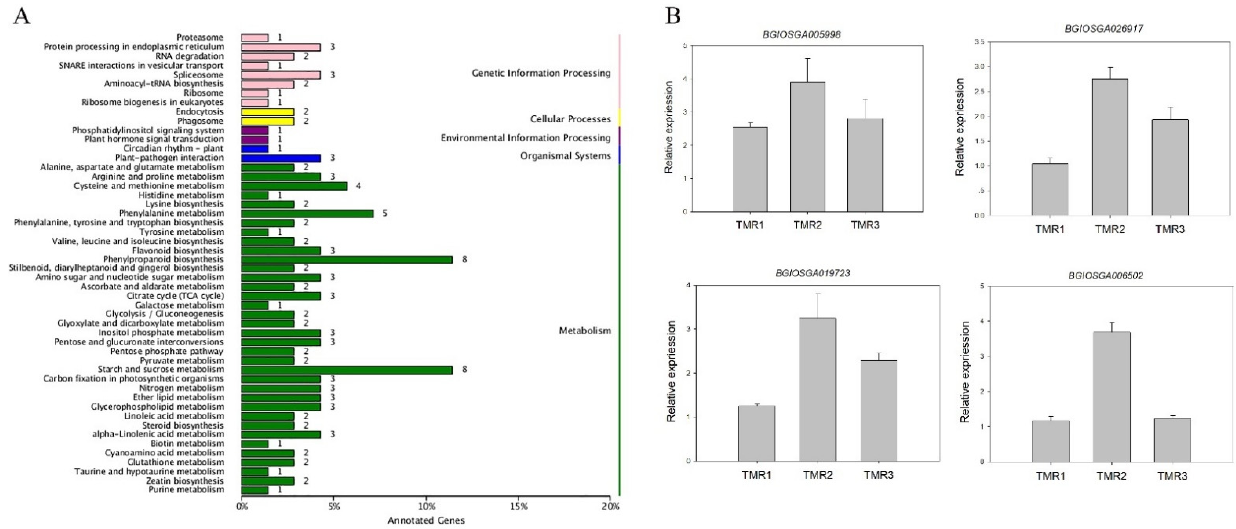
Figure 4. The changes of rice transcriptome fed by BPHs with/without rifampicin treatment. ( A ) KEGG pathway enrichment analysis of the DEGs comparing the rice fed by BPH with/without rifampicin treatment. ( B ) Quantitative real-time PCR validation of the expression changes in the four genes enriched in the phenylpropanoid biosynthesis pathway. The error bars were S.D.